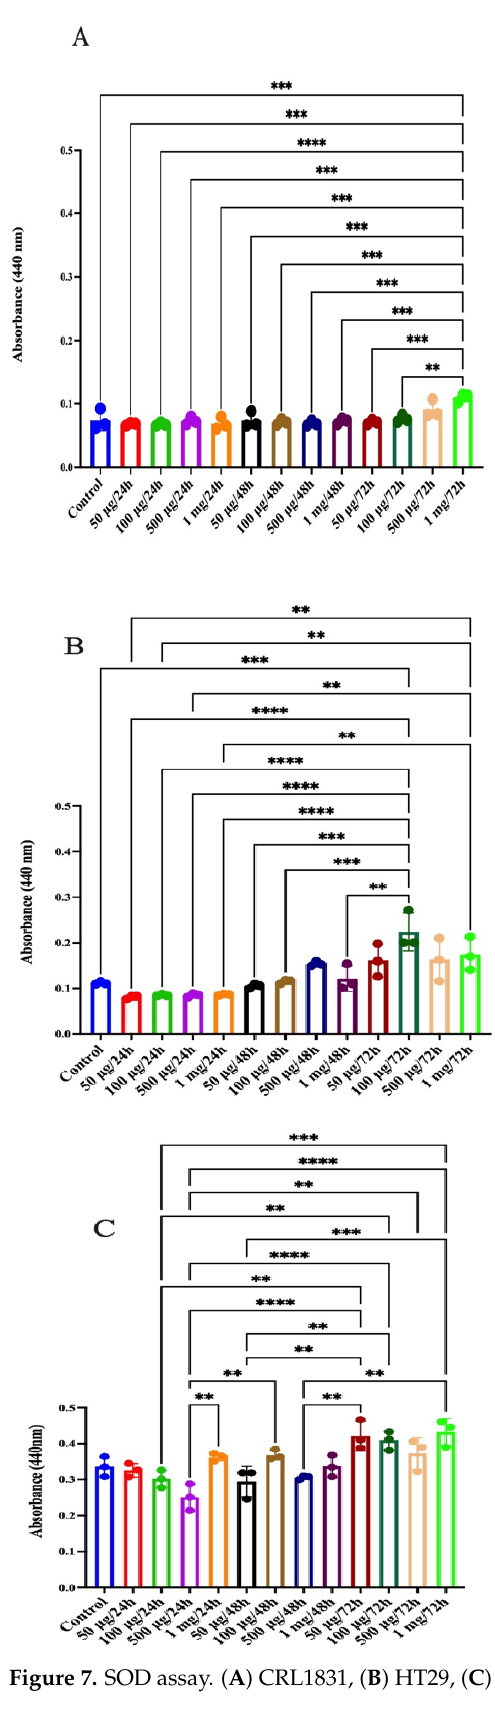
Figure 7. SOD assay. ( A ) CRL1831, ( B ) HT29, ( C ) SW480. (** p < 0.01, *** p < 0.005, **** p <